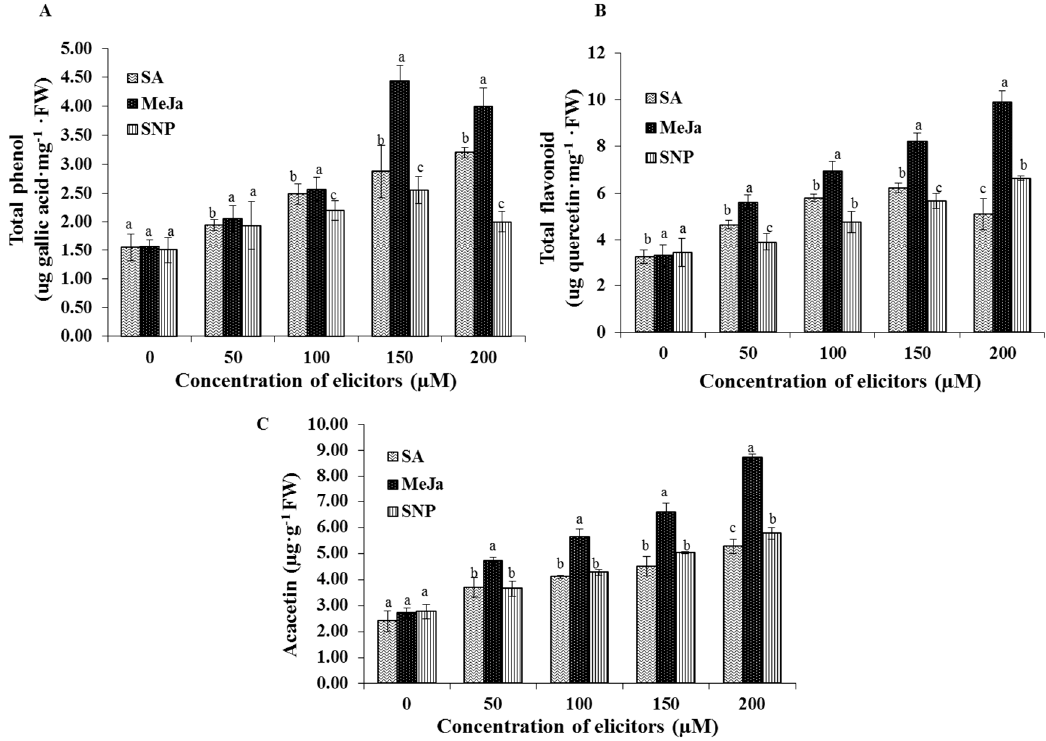
Figure 5. Effect of chemical elicitor treatments on the secondary metabolites. Total phenol content ( A ); total flavonoid content ( B ); and acacetin content ( C ) of cell suspension cultures. Data are the mean ± SE from three replicates. Different letters (a, b, c) in one measurement indicate statistically significant difference at p ≤ 0.05 by Duncan multiple range test.